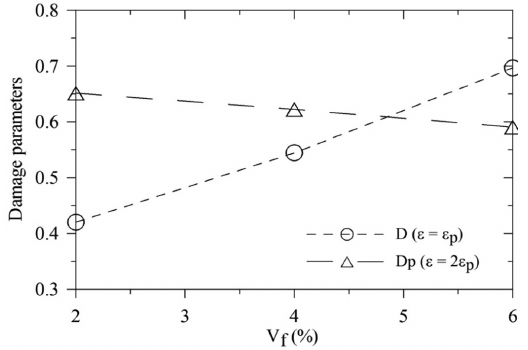
Figure 9. Effect of fibre content on the damage parameters D and D